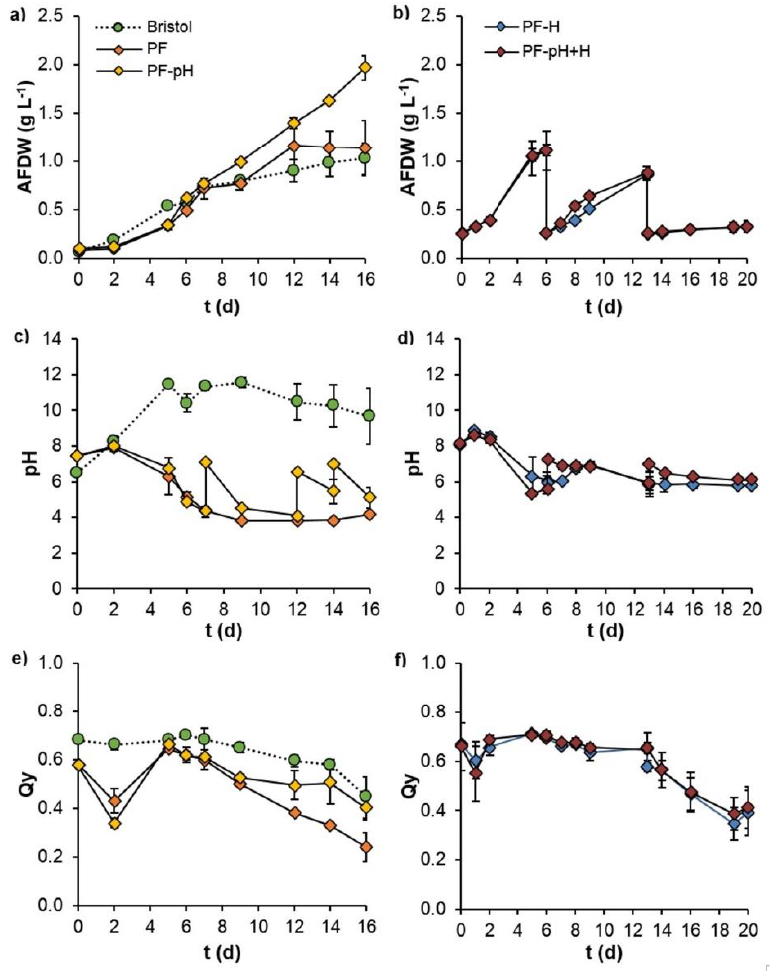
Figure 7. ( a , b ) Growth curves in ash-free dry weight (AFDW), ( c , d ) pH, and ( e , f ) quantum yield (Qy) of Tetradesmus obliquus in piggery wastewater pretreated by Photo-Fenton with combined optimization strategies (PF: no pH control or weekly harvesting; PF-pH: only pH control; PF-H: only weekly harvesting; PF-pH + H: pH control and weekly harvesting). Bristol medium was used as the control. Values are presented as mean ± mean deviation (n = 2).